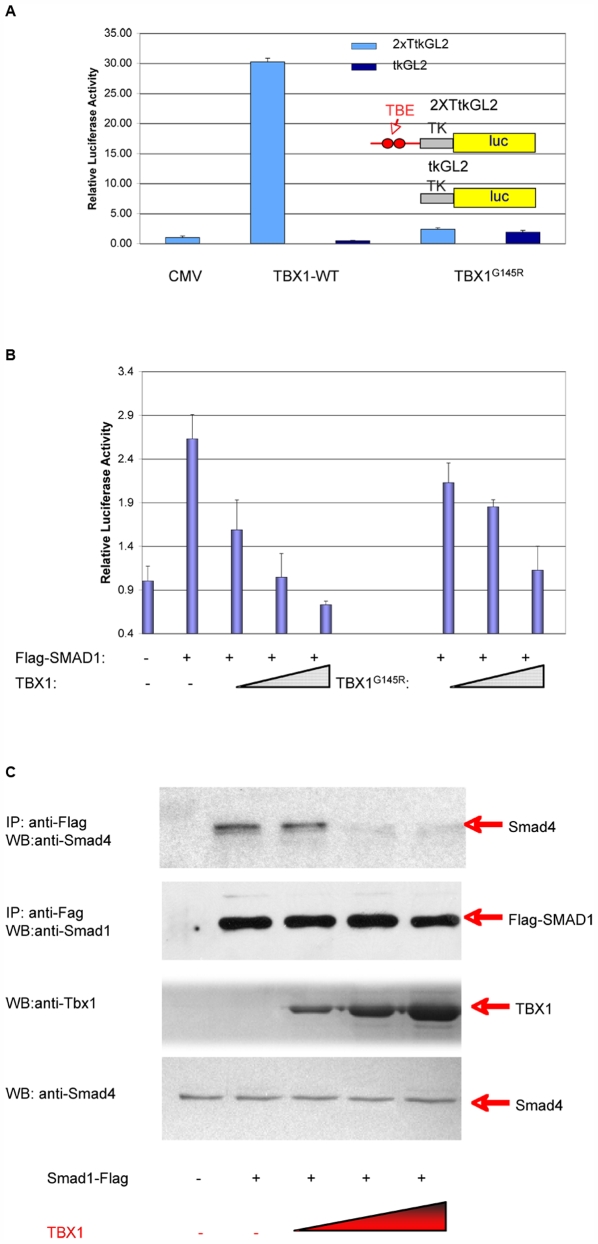
Transactivation ability of Tbx1 is not required for Smad pathway suppression; Tbx1 interferes with Smad1/Smad4 binding.a) A luciferase assay showing the inability of the TBX1G145R mutant to transactivate a T-box reporter construct in Jeg3 cells. Error bars indicate the standard error mean. b) A luciferase assay with a SMAD reporter showing that the mutant is capable of suppressing SMAD transactivation. c) Western blot analyses of nuclear extracts from C2C12 transfected with Tbx1 and SMAD1-flag expression vectors (as indicated). The top two rows are samples immunoprecipitated with an anti-flag antibody. The bottom two rows are non-immunoprecipitated nuclear extracts from the same samples. Note the strong reduction of Smad4 co-immunoprecipitated with Smad1 in the presence of transfected TBX1.